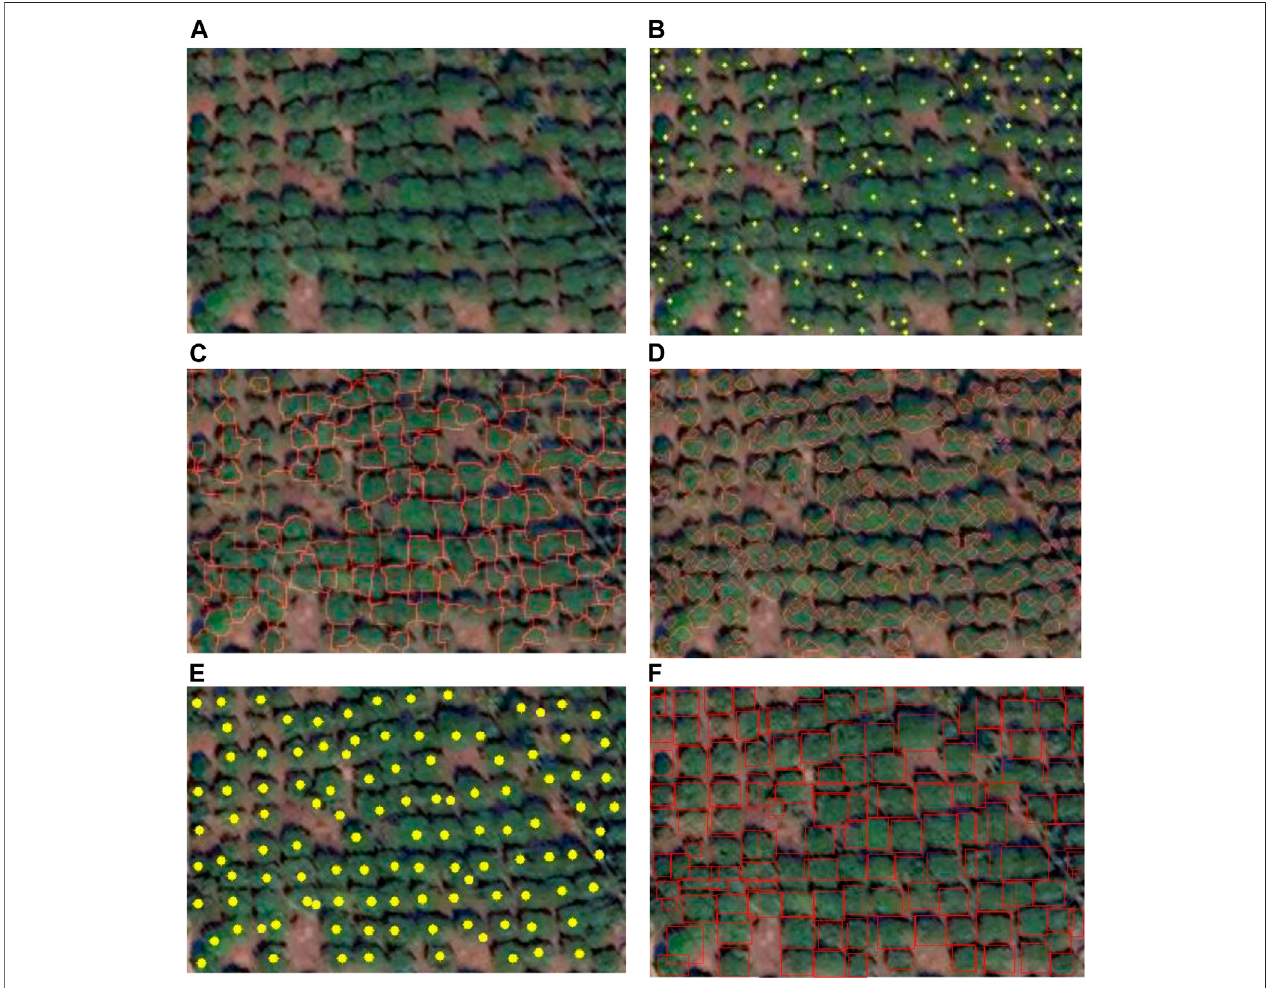
FIGURE 8 | Results of different methods in lychee plantation. (A) Original image. (B) Local max. (C) Watershed. (D) CV model. (E) Template matching. (F) SSD.